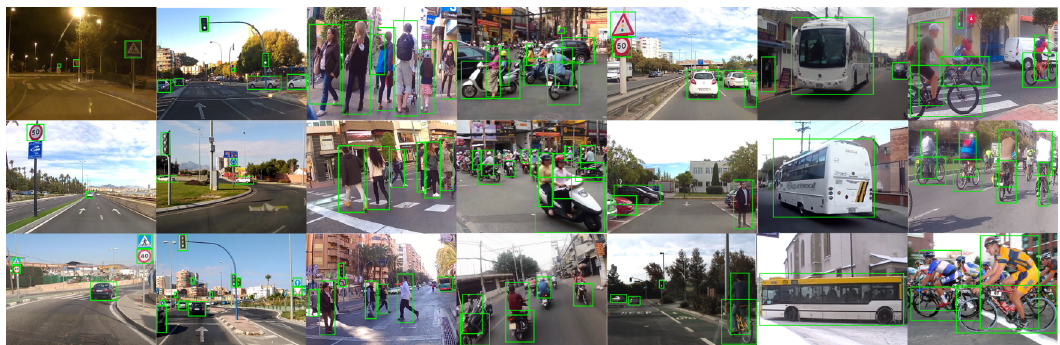
Figure 3. Image samples from the proposed dataset (seven